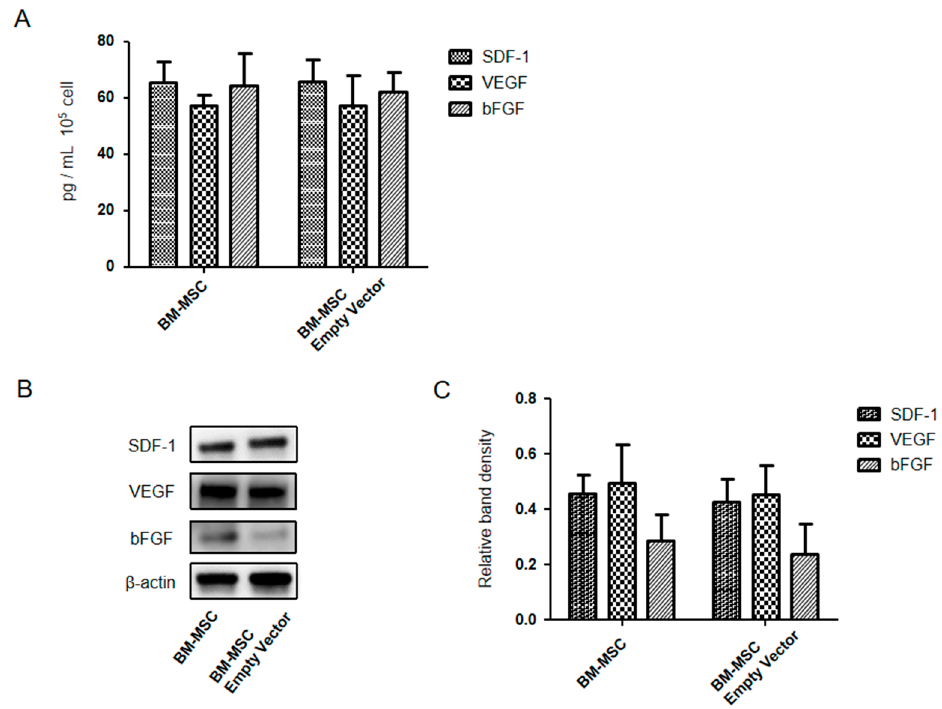
Figure 9. In vitro expression levels of SDF-1, VEGF, and bFGF were compared between BM-MSCs and empty vector engineered BM-MSCs passage 10 by quantitative ELISA and western blotting. ( A ) SDF-1, VEGF, and bFGF concentration in vitro by ELISA; ( B ) Expression levels of SDF-1, VEGF, and bFGF in vitro by western blotting; ( C ) Relative density of bands in the western blot analysis for each group.